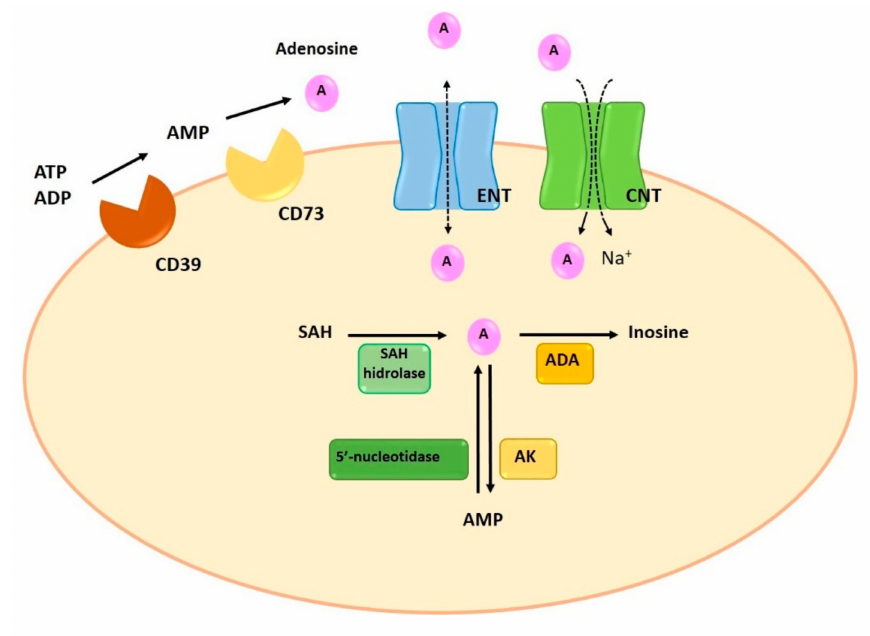
Figure 2. Synthesis, degradation and transport of adenosine. Intracellularly, adenosine is generated by dephosphorylation from AMP, by 5 (cid:48) -nucleotidase, or by hydrolysis of SAH, by SAH hydrolase. Extracellular adenosine generation is the result of the enzymatic activity of CD39 and CD73. ENT and CNT transporters allow the reuptake of adenosine. Finally, the adenosine is metabolized intracel- lularly by two enzymes, ADA and AK, which will produce inosine and AMP. ADA: